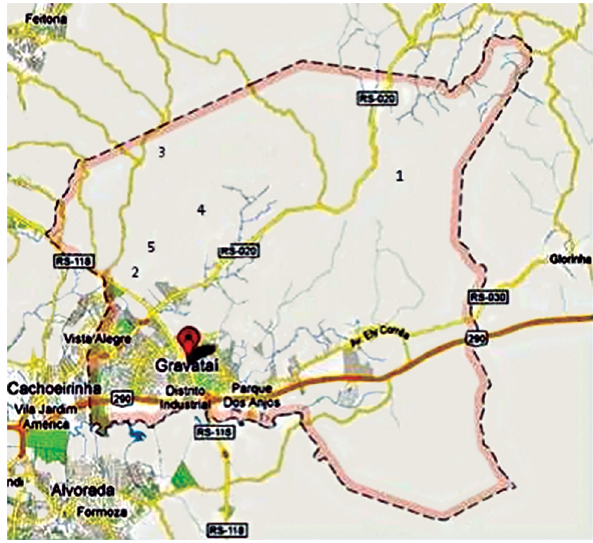
Figura 1. localização do município de Gravataí, e das uP trabalhadas (uP 1 a